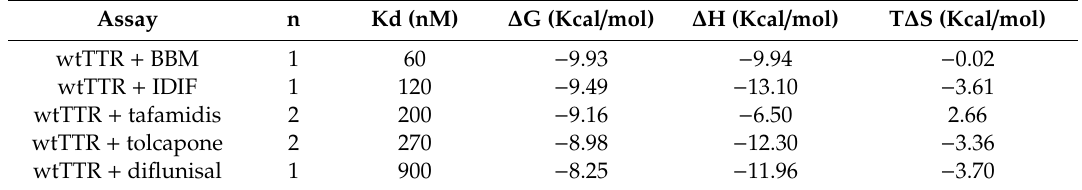
Table 1. Thermodynamic parameters for interaction of TTR with small-molecule compounds including some TTR stabilizer drugs analyzed by